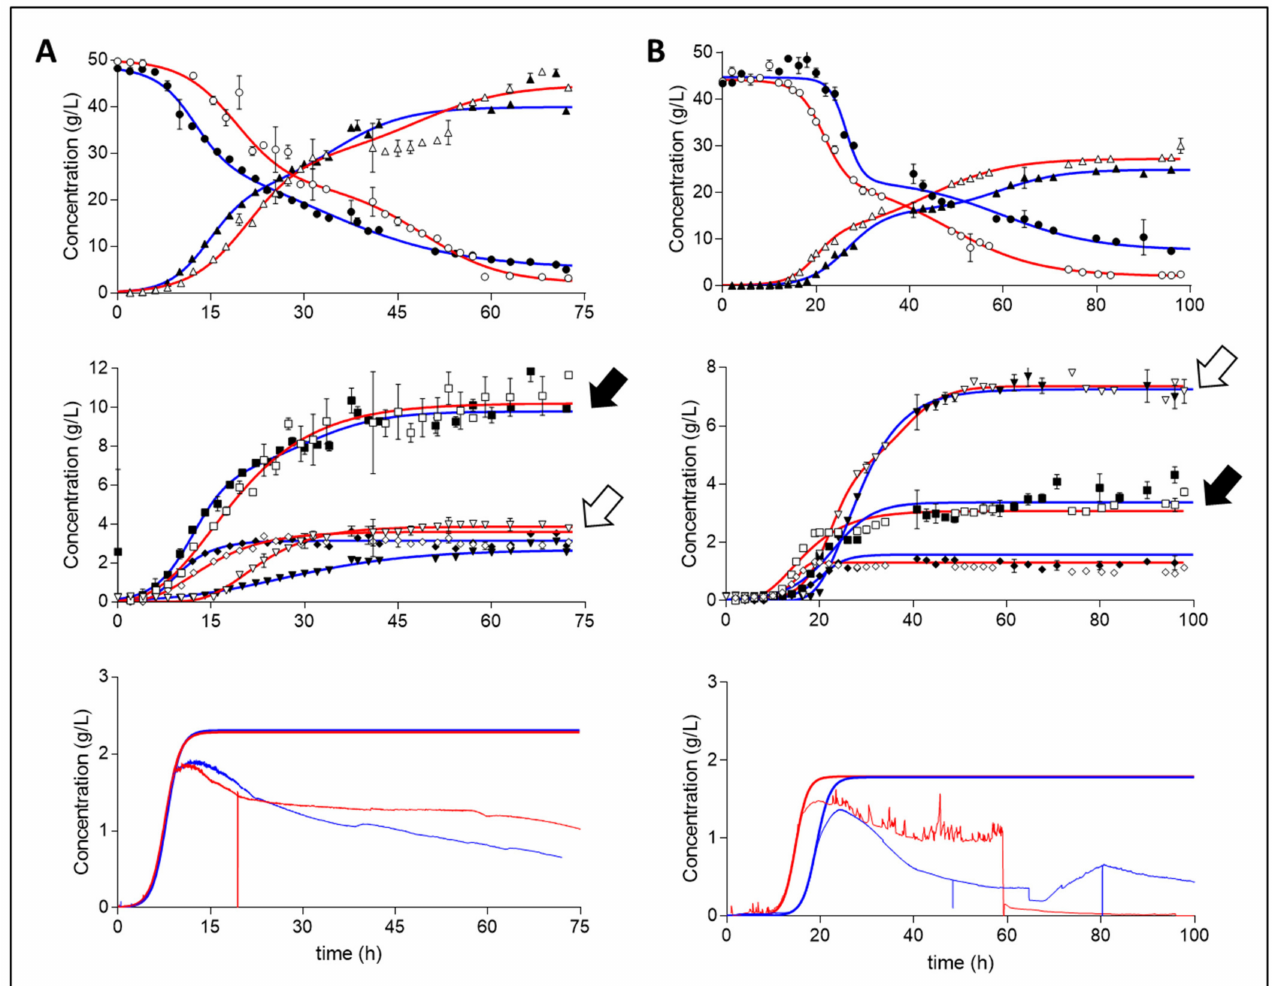
Figure 1. Repeat batch concentration profiles (g/L) of A. succinogenes on media ( A ) and media ( B ). Legend: dextrose (Dex), ; succinic acid (Suc), (cid:52) ; acetic acid (Ace), (cid:3) ; formic acid (For), ; pyruvic acid (Pyr), σ ; repeats are indicated as filled (cid:35) (cid:51) shapes with blue fits. Biomass profiles (bottom) display online OD 660 absorbance data and their logistic fits, with the top parameter fixed to a final DCW determined concentration. Black arrows (acetic acid) and white arrows (pyruvic acid) highlight the shift in their relative abundance between the two